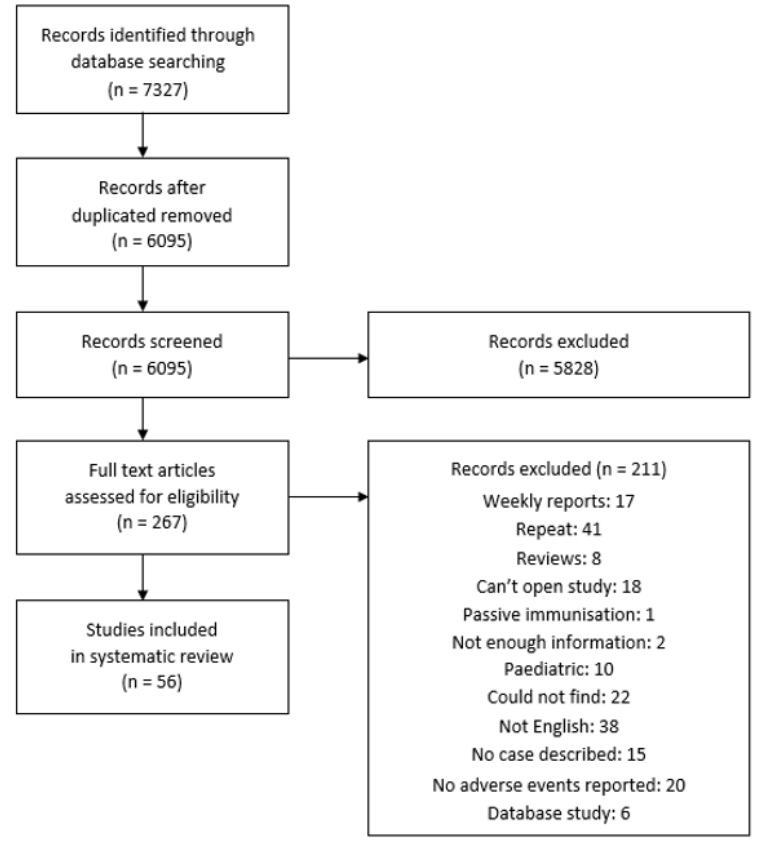
Figure 1. Preferred Reporting Items for Systematic Reviews and Meta-Analyses (PRISMA) Flow diagram. The median age for developing cardiac AEs following vaccination was 43.79 ± 21.2 years. Most of the patients described were males (84%) and rest were females (Table 1). Table 1. Summary of Vaccine Related Cardiac Adverse Events. Vaccine Type No. of Studies No. of Patients Average Time of Symptom Onset from Vaccination (Days)